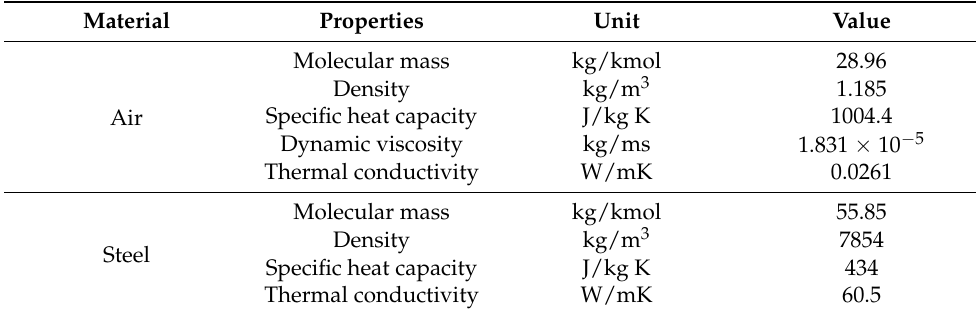
Figure 6. Boundary conditions and the meshing model at the insert area. Table 1. Material properties (for simulation).